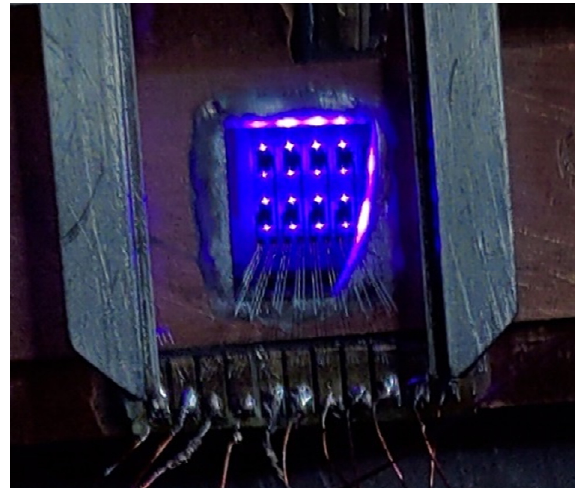
Figure 9. Light emission from the proposed 2D array of horizontal-to-vertical surface- emitting laser diodes.